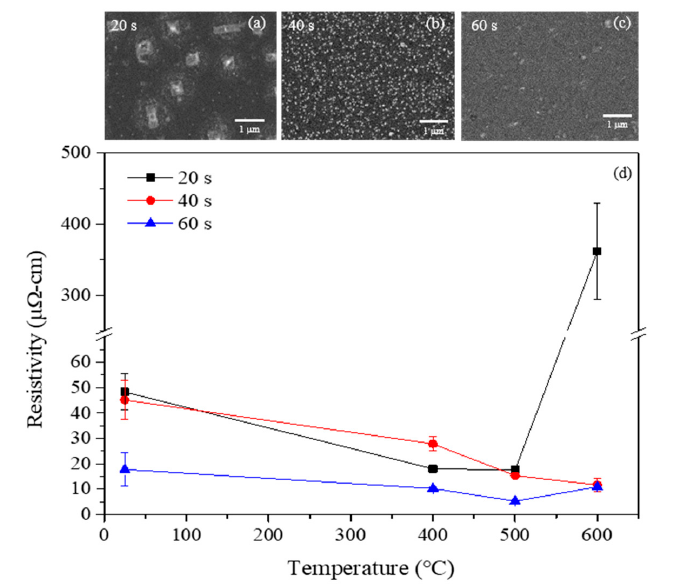
Figure 7. The surface morphologies of the 600 °C-annealed Cu(Mn) films deposited at the terminated OCP time of ( a ) 20 s, ( b ) 40 s, ( c ) 60 s, and ( d ) the electrical resistivity changes for the studied Cu(Mn) films annealed at an elevated temperature.